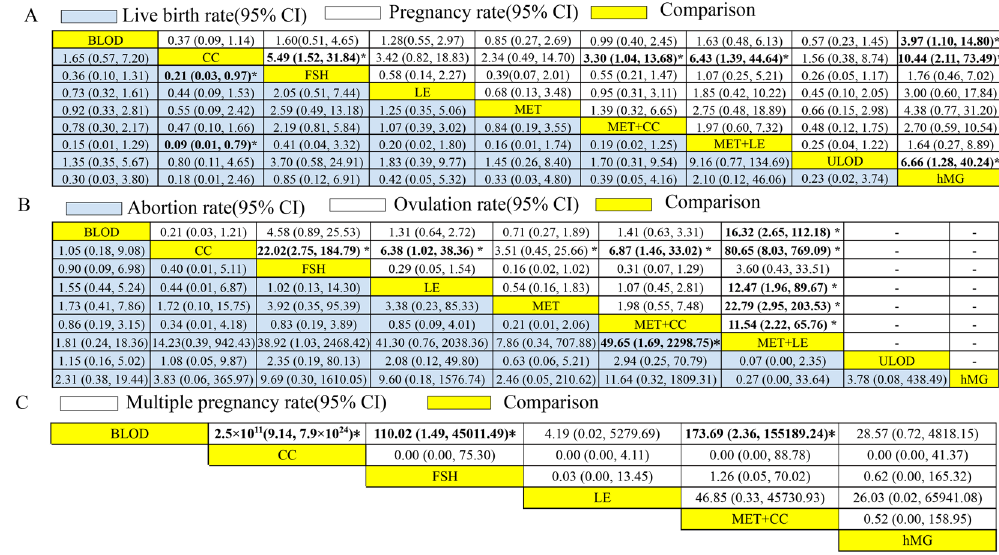
Figure 5. Results of network meta-analysis. Results are shown as OR (95%CI), representing column-defining treatment versus row-defining treatment. For pregnancy rates, live birth rates and ovulation rates, ORs higher than 1 favoured the column-defining treatment. For abortion rates and multiple pregnancy rates, ORs lower than 1 favoured the column-defining treatment. Significant results are shown in bold with “ * ” at the top right corner. CC: clomiphene citrate, MET: metformin, LE: letrozole, FSH: follicle-stimulating hormone, hMG: human menopausal gonadotropin, MET + CC: metformin combined with clomiphene citrate, MET + LE: metformin combined with letrozole, ULOD: unilateral laparoscopic ovarian drilling and BLOD: bilateral laparoscopic ovarian drilling. CI: confidence interval. “-” indicates